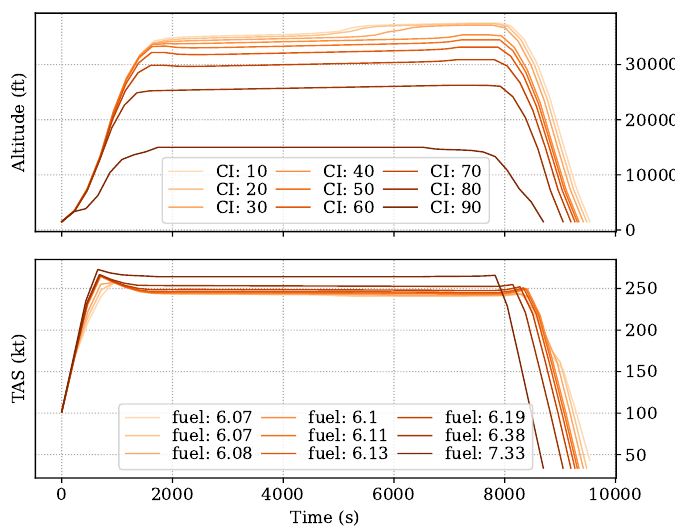
Figure 9. Trajectory optimized for different cost index (A320, with 85% of maximum takeoff mass). The experiment resulted in different fuel consumption shown in the second plot. The decrease in flight duration can be seen by the total flight time of each trajectory, with an increasing cost index